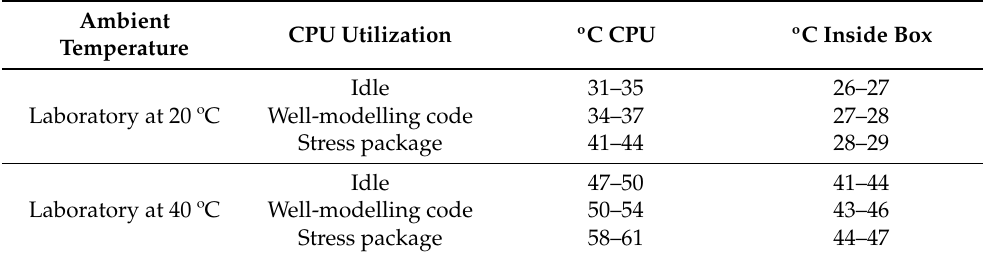
Table 1. Temperature ranges (Celsius degrees ºC) of the BOX and SoC with two different external ambient temperatures.